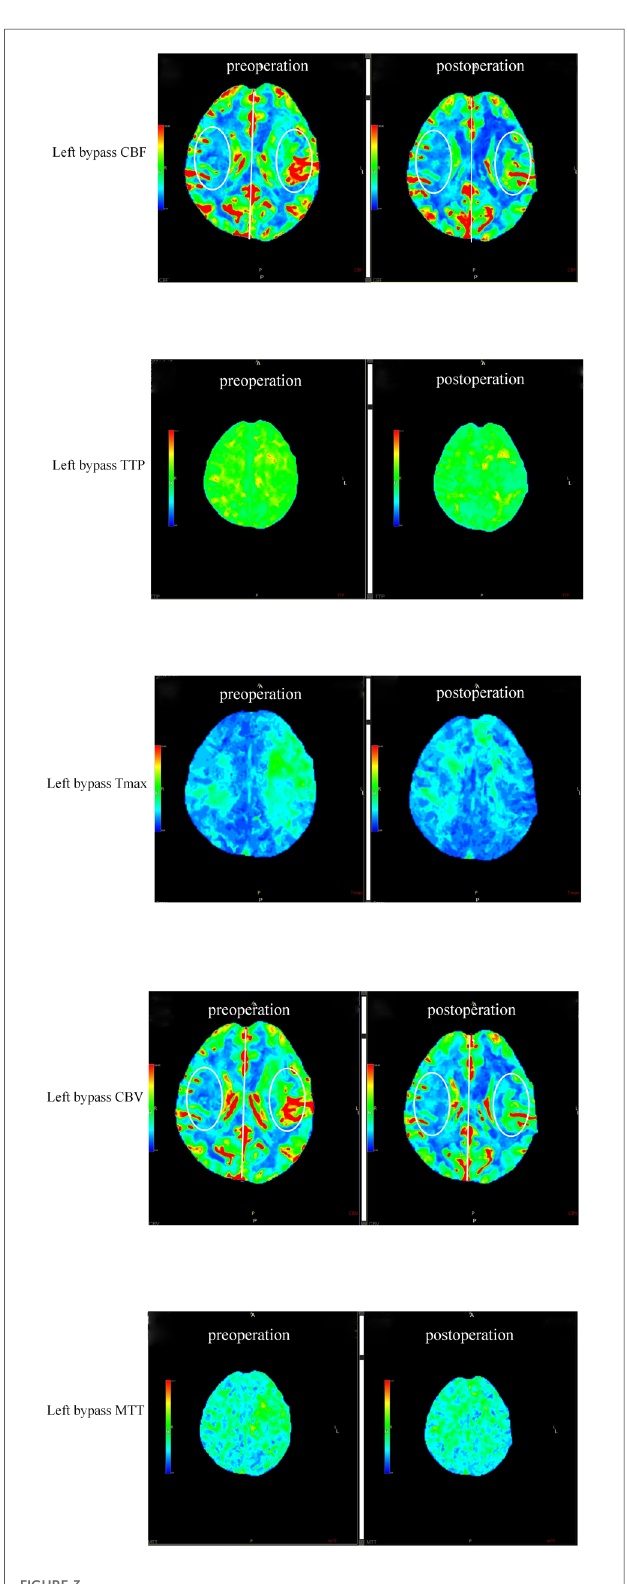
FIGURE 3 Representative images of CTPs before and after surgery. Images with fi ve parameters: CBF, TTP, Tmax, CBV, and